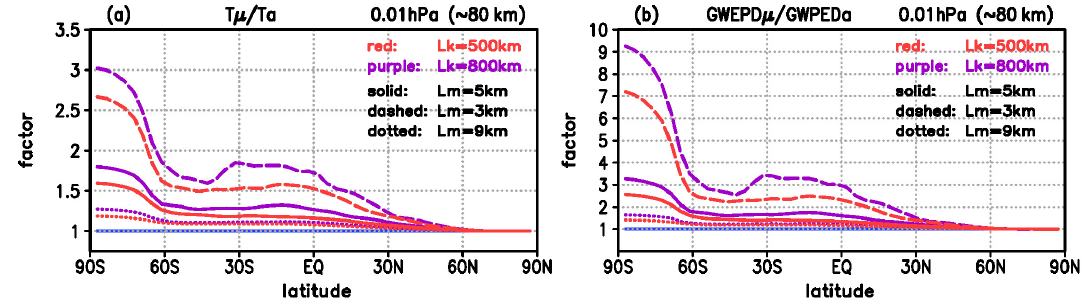
Figure 6. Cumulative amplification of the GW amplitudes similar to that in Fig. 5, but at upper mesospheric levels (0.01hPa, ∼ 80km) for different horizontal and vertical wavelengths L k (red: 500km, purple: 800km) and L m (dotted: 9km, solid: 5km, dashed: 3km), (a) T µ /T a , (b) E µ /E a